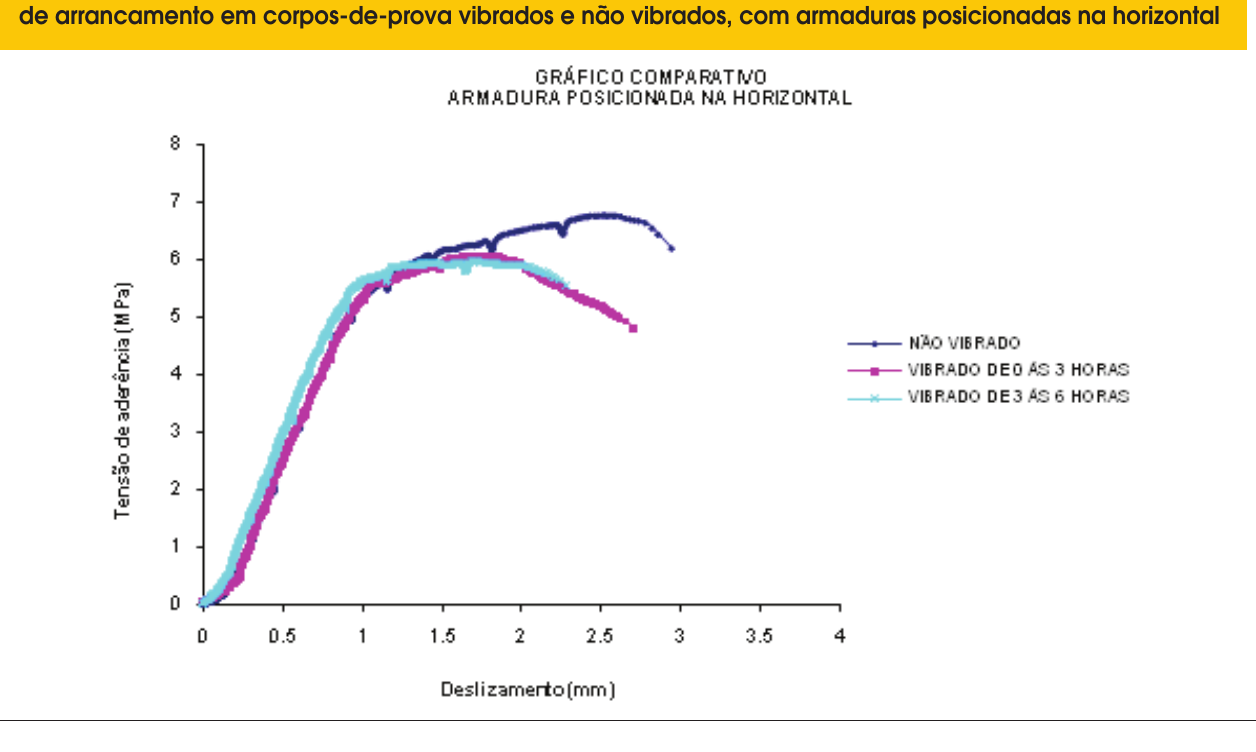
Figura 3 – Gráfico comparativo da evolução da tensão de aderência e deslizamentos da barra durante ensaios